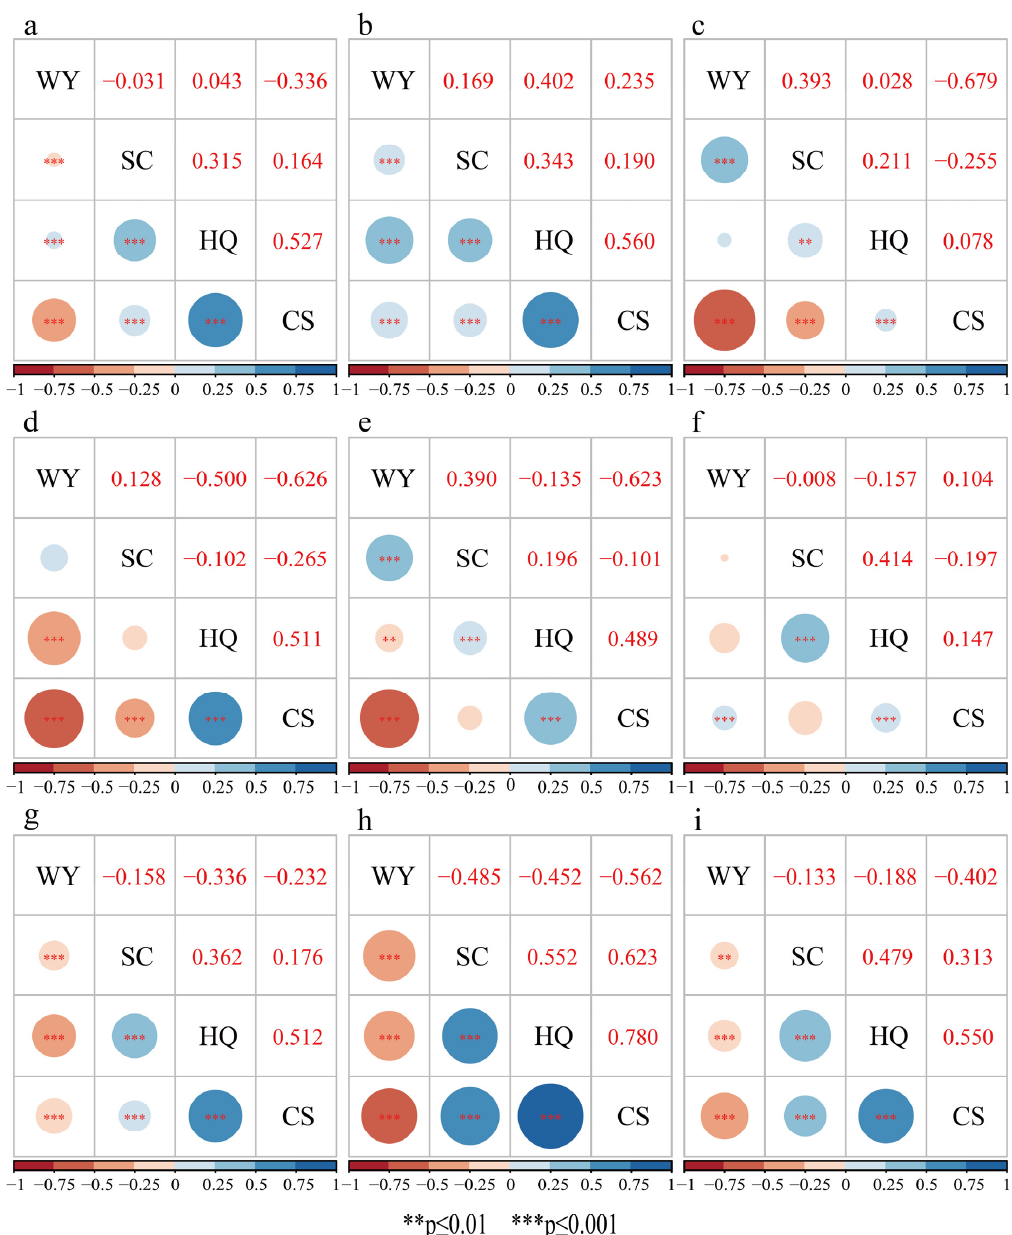
Figure 8. Correlation of ecosystem services in mining areas. Note: WY: water yield; SC: soil conservation; HQ: habitat quality; CS: carbon storage; ( a ): Coal Mine; ( b ): Iron Mine; ( c ): Diorite; ( d ): Granite; ( e ): Limestone; ( f ): Dolomite; ( g ): Shale; ( h ): Clay; ( i ): Building Sand. Overall, the mining ecosystem services were moving toward trade-offs. The study area had a slight trade-off between WY and CS. However, within the amphibolite, granite, and chert mines, the R-value between WY and CS was below − 0.600 ( p < 0.001), reflecting a significant trade-off. The R-values between WY and HQ were negative in six of the nine mineral zones, and their trade-offs were stronger than the whole study area. The relationship between SC and HQ was positively correlated within mineral zones, and its R-value was even higher than those of the entire study area in some mineral zones, indicating stronger synergistic relationships than those of the entire study area. HQ and CS were positively correlated within mineral zones, but their synergistic relationships were weaker than the whole study area. The relationship between WY and SC and that